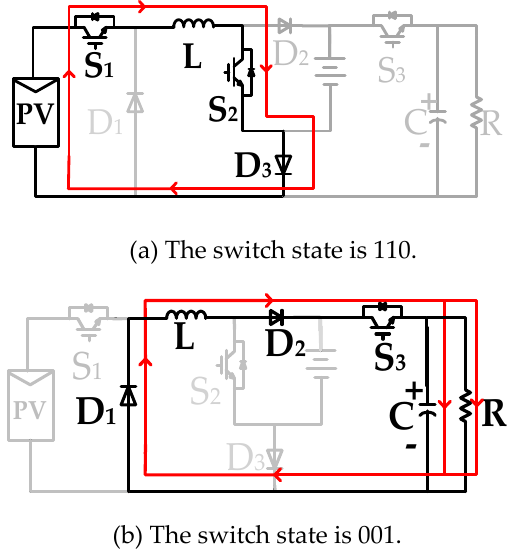
Figure 8. Waveforms in single input single output (SISO) mode.